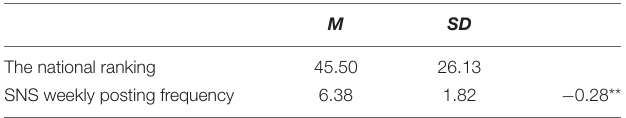
TABLE 1 | Results of descriptive statistics and correlation analysis ( N =